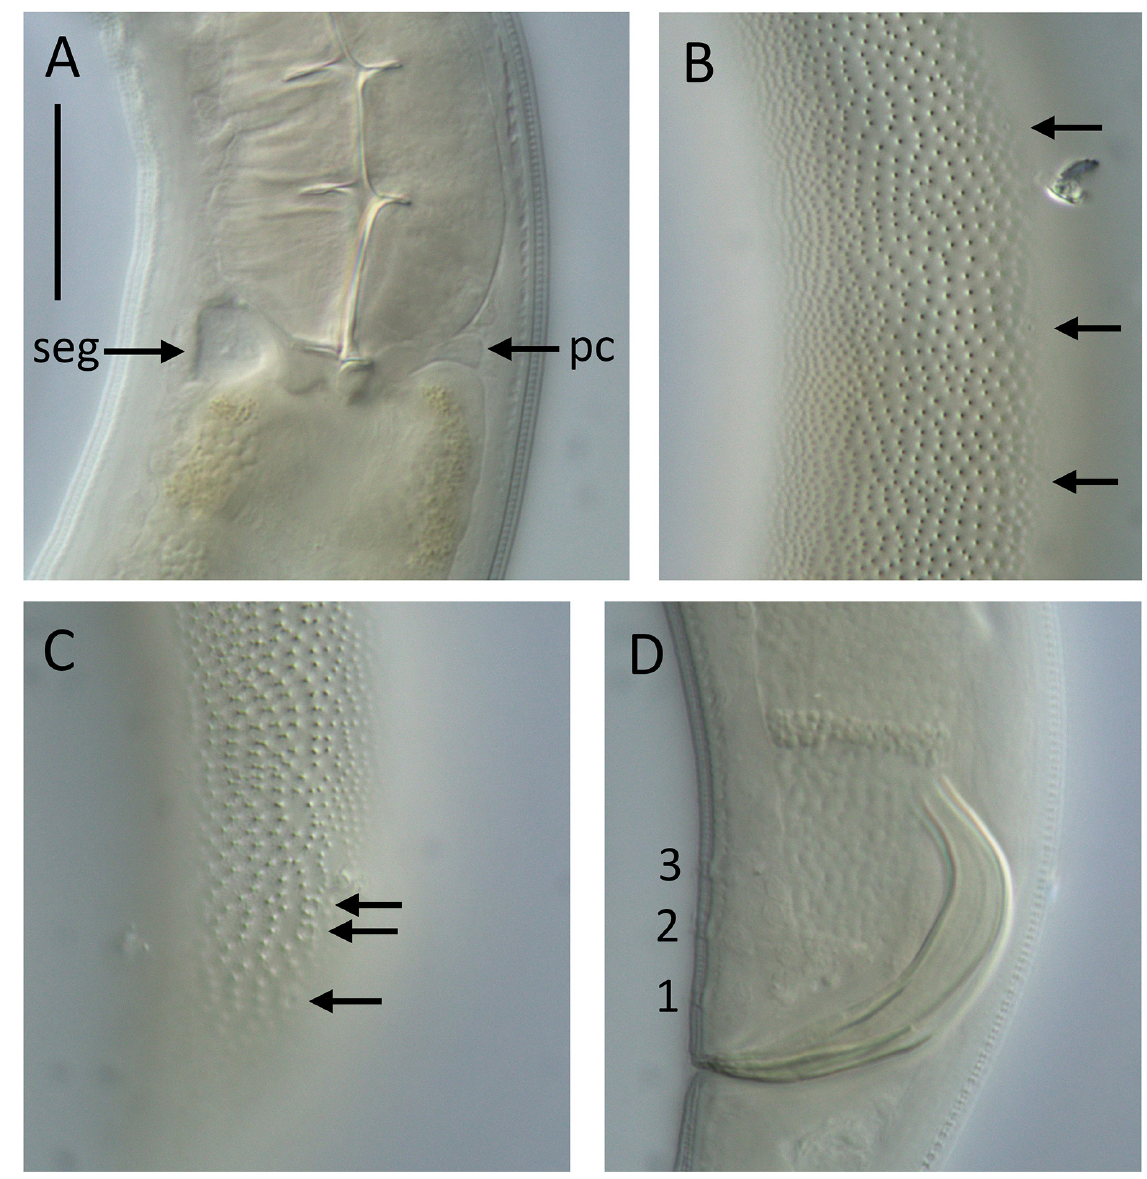
Fig. 11. Halichoanolaimus pumilus sp. nov. Light micrographs of holotype ♂ (NIWA 139250). A . Junction of pharynx and intestine, showing position of secretory-excretory gland (seg) and pseudocoelomocyte (pc). B . Mid-body cuticle, showing position of pore complexes (arrows). C . Cuticle near tail region, showing position of pore complexes (arrows). D . Spicular apparatus and precloacal supplements (numbered 1 to 3). Scale bar = 20